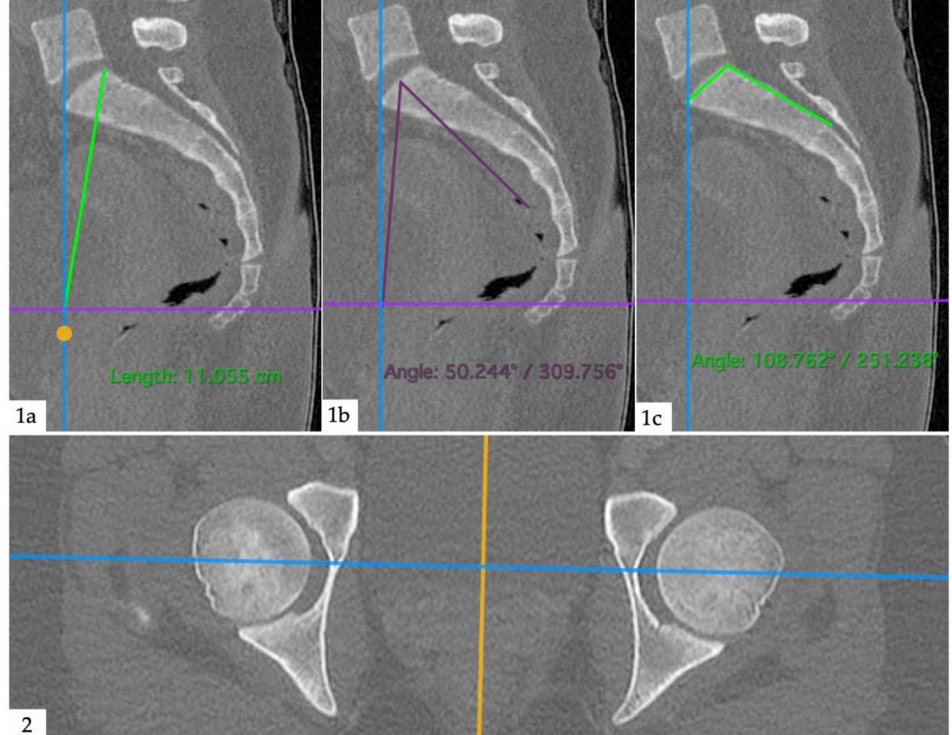
Figure 3. Anatomical measurements. ( 1a ): Pelvic radius; distance between posterior–superior corner of the first sacral vertebra and the center of a line between the femoral heads (intersection between blue and violet lines). ( 1b ): Pelvic incidence; angle between a line from the center of a line between the two femoral heads and the center of the sacral plateau and a line perpendicular to the sacral plateau. ( 1c ): Sacral table angle; angle between the posterior wall of the sacrum and the sacral plateau. ( 2 ): Second plane (axial) to aid